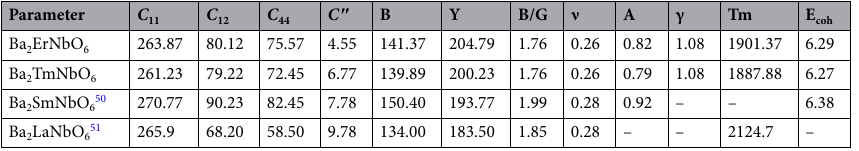
Table 2. Reported second-order elastic constants and mechanical stability of Ba 2 ErNbO 6 and Ba 2 TmNbO 6 perovskite at “0 GPa” and “0